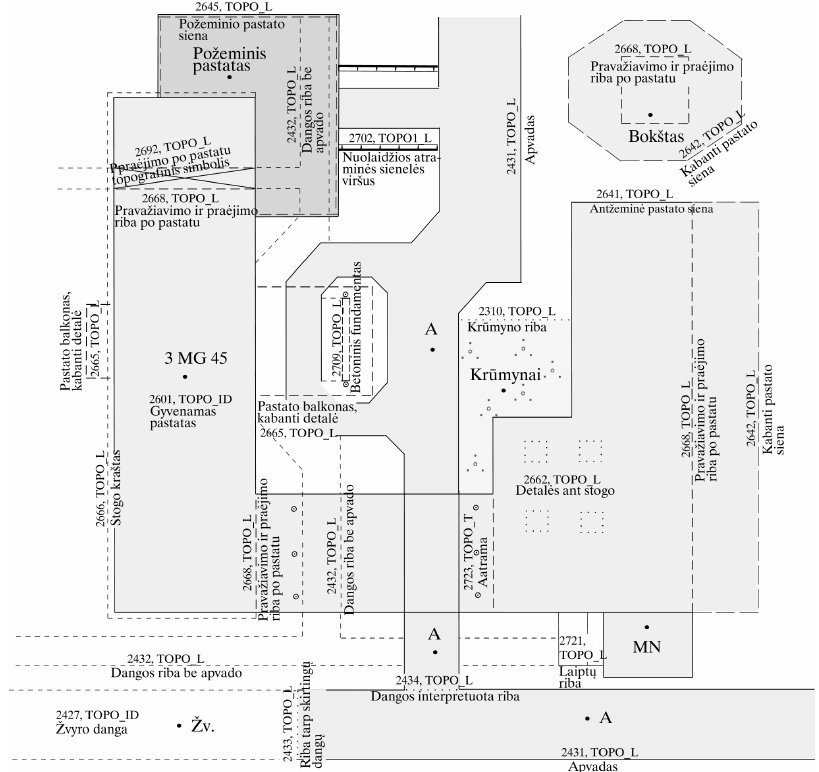
Fig 2 . Separating the territory into geoobjects